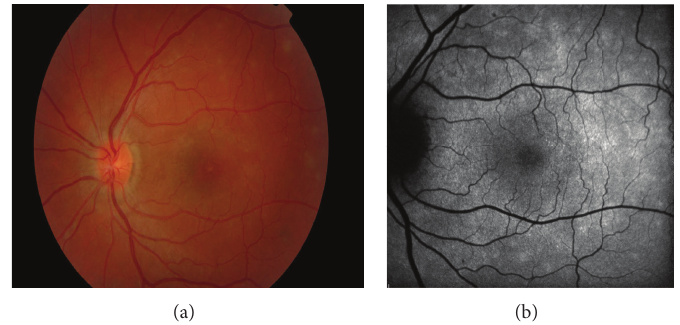
Figure 4: Areas of hyperautofluorescence in multiple evanescent white dot syndrome. (a) Colour fundus images showing multiple small yellow-white spots and fine orange granularities at the fovea. (b) FAF of the same eye showing multiple ill-defined spots of hyperautofluores-